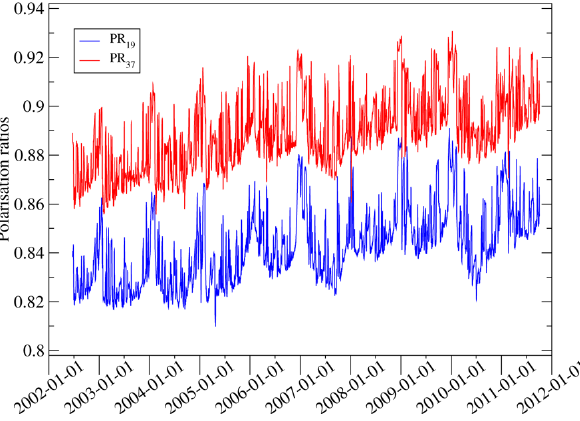
Fig. 11. Time series of polarisation ratios at 19 and 37GHz at Dome C, from 19 June 2002 to 3 October 2011.